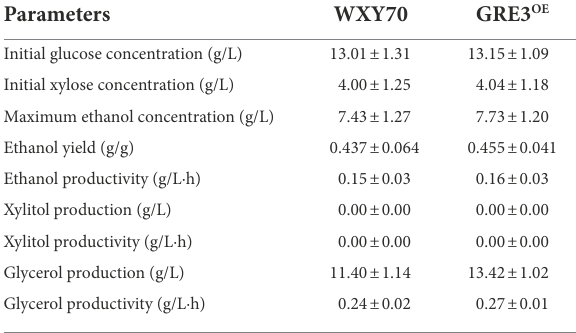
TABLE 3 Comparison of fermentation profile in sorghum straw hydrolysate fermentation between WXY70 and GRE3 OE of the 48 h.